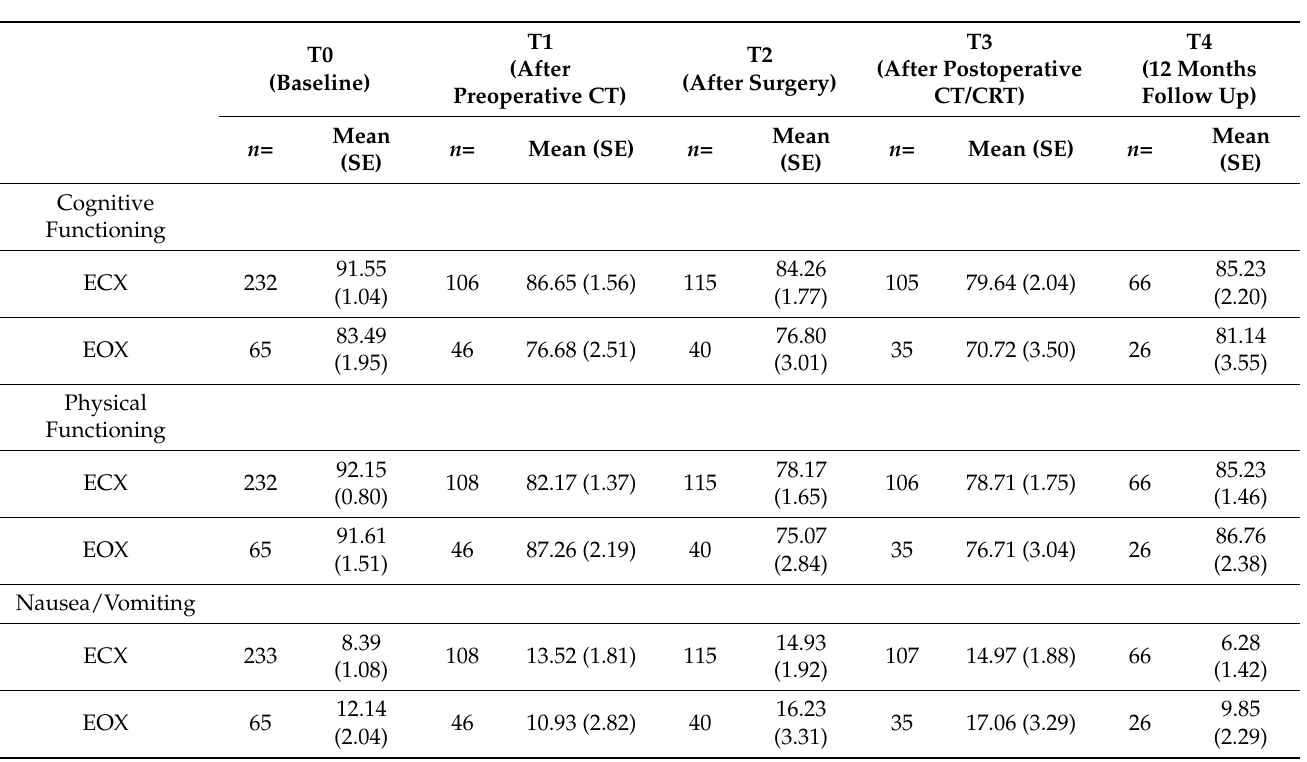
Figure 2. Overall-survival estimates for patients treated with ECX versus EOX. HR 0.84 (95% CI 0.61–1.17). Table 4. Quality of Life items on a 0–100 scale. SE = standard